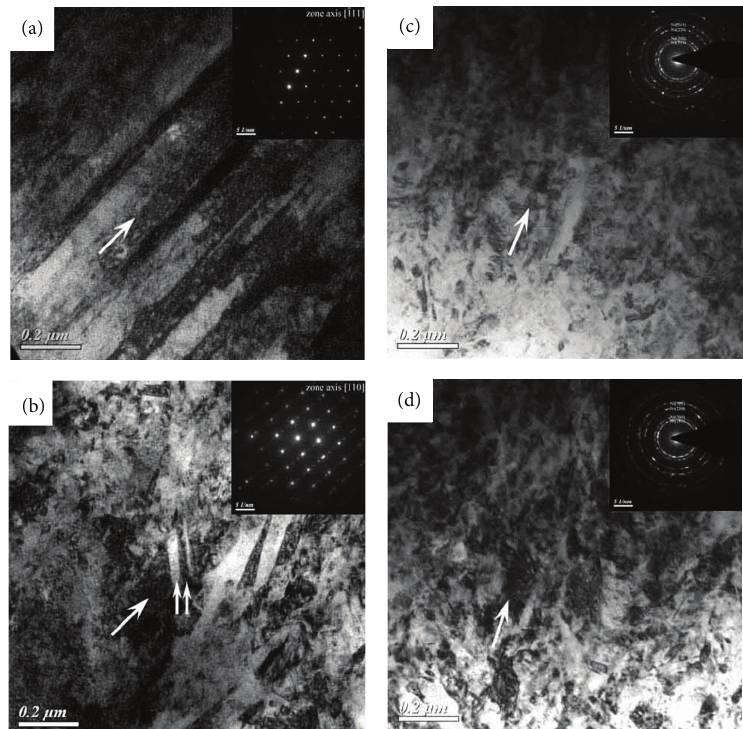
Figure 4: The cross-sectional micrographs of TEM examinations on the coatings prepared at different current densities: (a) 2 A/dm 2 , (b) 8 A/dm 2 , (c) 10 A/dm 2 , and (d) 12A/dm 2 . Single arrow denotes the direction of columnar grain, while double arrows indicate the presence of twins. The corresponding insets are the SAED patterns measured at location of pointed arrows.